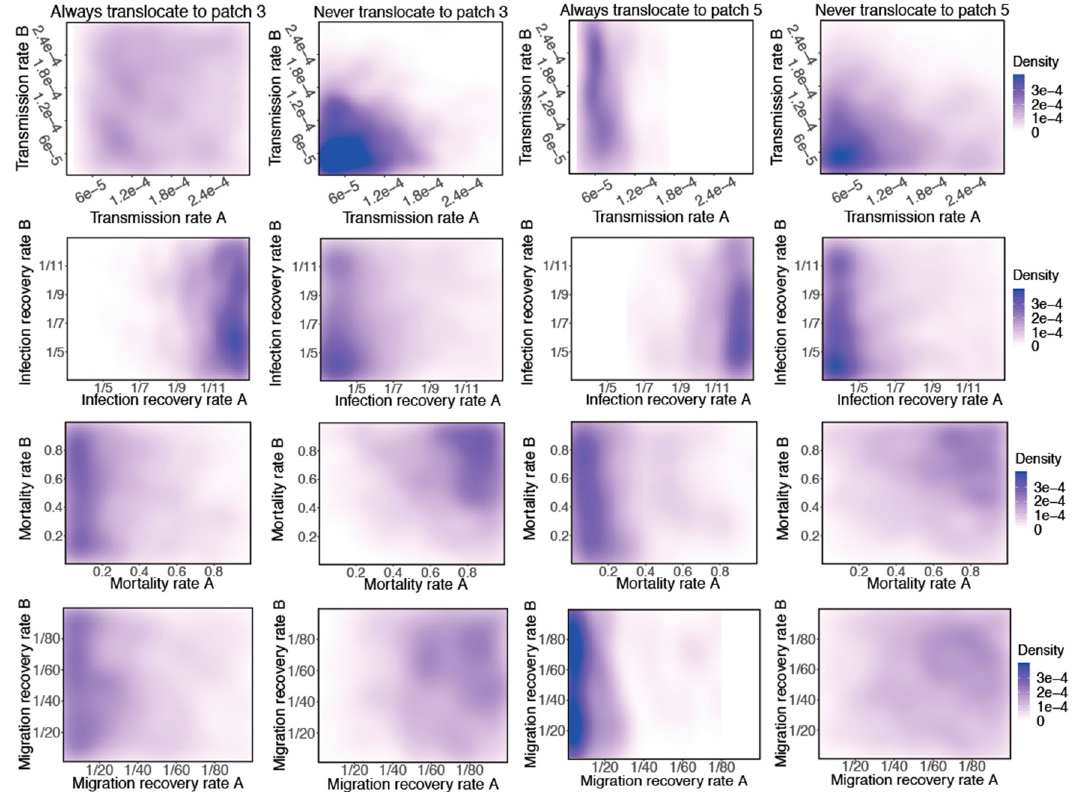
Figure 4. Two-dimensional kernel density for each of the four core parameters in Flocks A and B that always and never support translocating to Patches 3 and 5. A parameter combination always supports translocation if the virus appears in a given patch during 100% of runs with that parameter combination and never supports translocation if the virus appears in a given patch during 0% of runs with that parameter combination.